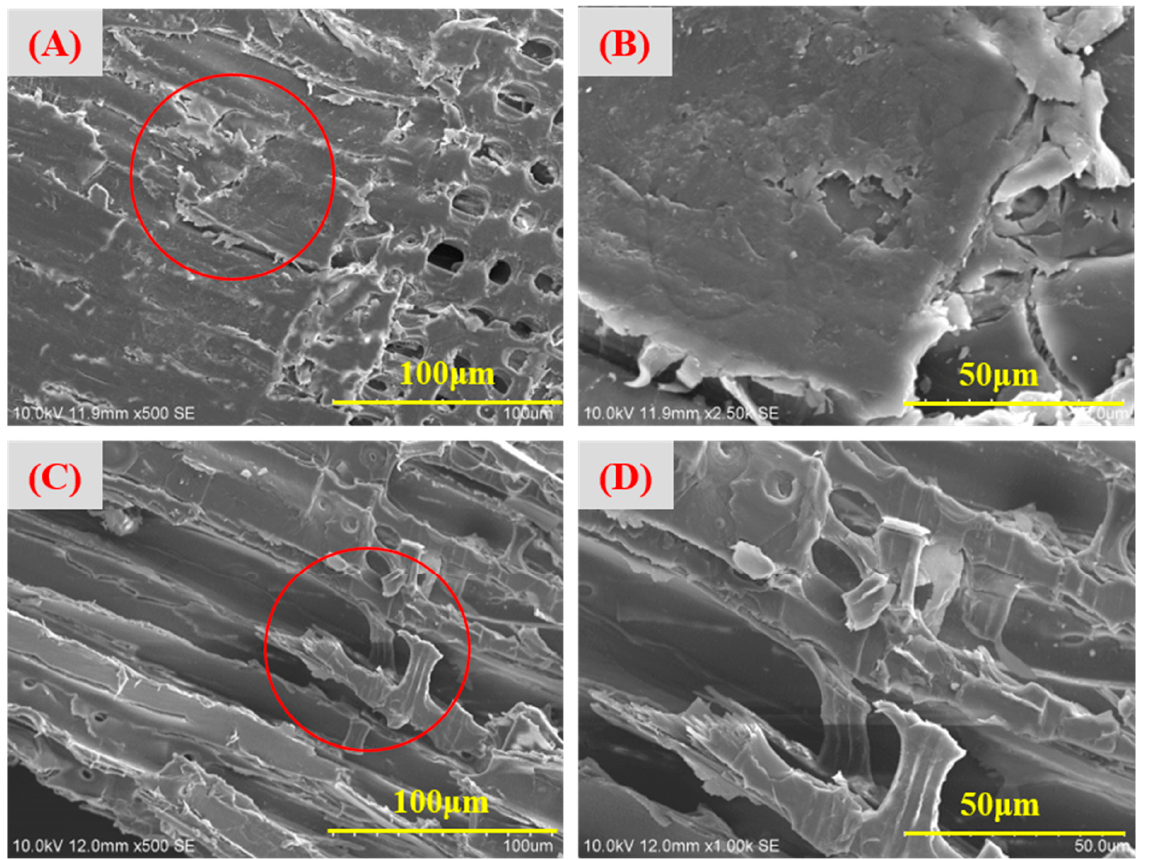
Figure 1. Micro-morphology of CCA-treated wood before treatment at 100 µm ( A ) and 50 µm scale ( B ); after treatment with uninoculated medium for 21 d at 100 µm ( C ) and 50 µm scale ( D ). Compared to the original strains, the Cu 2+ -domesticated strains had an ellipsoidal shape and partially changed into much smaller particles (Figure 2D–F). These observations agreed with the results of digital images of the fungi, as shown in Figure 3 and Table